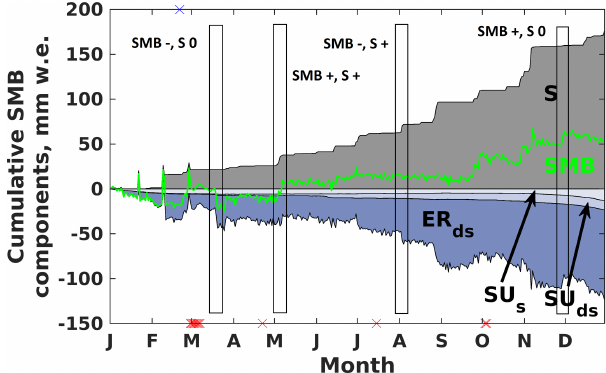
Figure 2. Cumulative daily surface mass balance components dur- ing 2012 at the Princess Elisabeth station: snowfall ( S ), surface sub- limation (SU s ), drifting snow sublimation (SU ds ), wind-induced ac- cumulation and ablation (ER ds ), and accumulation and ablation de- duced from measured snow height changes since 1 January 2012 (SMB; adapted from Gorodetskaya et al., 2015). SU s and SU ds are plotted as ablation terms. ER ds is calculated and plotted as a resid- ual term by inverting Eq. (1). Red crosses at the bottom indicate days of missing MRR data, while blue crosses at the top denote missing AWS data. Letters on the x axis mark the first day of each month. Examples of the four types of events defined in Sect. 2.2 are indicated with black